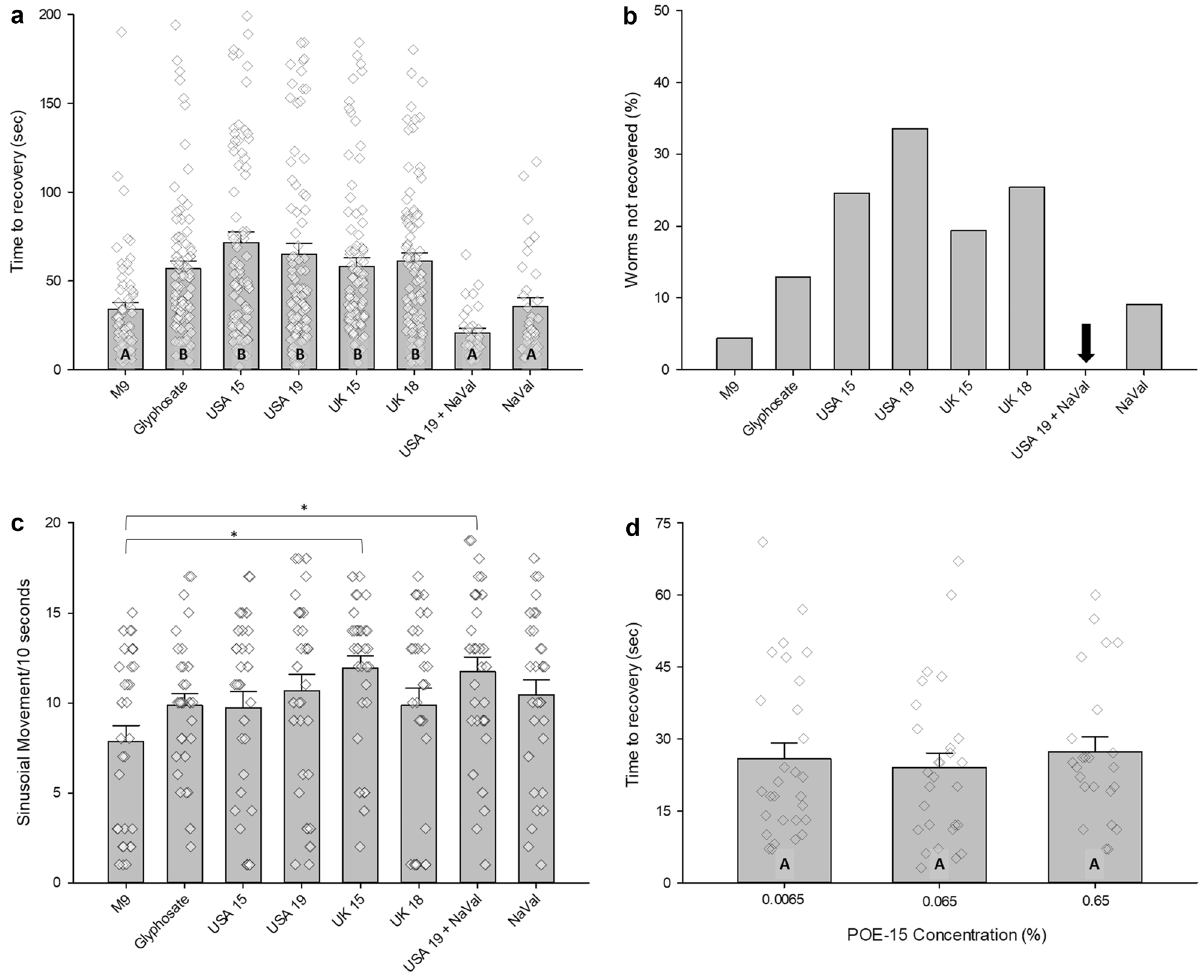
Figure 1. (a ) Average time to recovery for N2-wildtype nematodes, approximately 100 worms per condition, exposed to M9 saline (n = 65), glyphosate (n = 85), US formulations of Roundup from 2015 (n = 85) and 2019 (n = 104), UK formulations of Roundup from 2015 (n = 95) and 2018 (n = 96), the US formulation of Roundup from 2019 co-administered with 3 mM sodium valproate (n = 31), and sodium valproate by itself (n = 33). Glyphosate-containing treatments were normalized to 0.1 mM glyphosate. Data presented as mean seconds to recovery ± SEM. Raw data points were overlayed on the histograms. Statistical significance (p < .05) was designated using letters, where different letters show statistically significant differences, and the same letter indicates non-significance. P values between indicated conditions derived from a One-Way ANOVA followed by Student–Newman–Keuls Method for all pairwise multiple comparisons. ( b ) Percent of worms that did not recover from convulsion state when exposed to M9 saline (n = 69), glyphosate (n = 116), US formulations of Roundup from 2015 (n = 114) and 2019 (n = 158), UK formulations of Roundup from 2015 (n = 119) and 2018 (n = 130), the US formulation of Roundup from 2019 co-administered with 3 mM sodium valproate (n = 31), and sodium valproate by itself (n = 36). Data presented as (number of worms not recovered in condition X/total number of worms tested in condition X) × 100. Arrow indicates that all worms recovered in the condition. ( c ) Average number of complete sinusoidal movements per 10 s before induction of electroshock. N2-wildtype nematodes were exposed to M9 saline (n = 31), glyphosate (n = 32), US formulations of Roundup from 2015 (n = 31) and 2019 (n = 33), UK formulations of Roundup from 2015 (n = 32) and 2018 (n = 33), the US formulation of Roundup from 2019 co-administered with 3 mM sodium valproate (n = 31), and sodium valproate by itself (n = 31). Data presented as mean sinusoidal movement/10 s time window ± SEM. Raw data points were overlayed on the histograms. Statistical significance (p < .05) was designated using stars. P values between indicated conditions derived from Kruskal–Wallis One-Way ANOVA on ranks followed by Dunn’s Method for multiple comparisons versus M9 control group. ( d ) Average time to recovery data for N2-wildtype exposed to logarithmic dosage of percent POE (15) tallow amine, 0.0065% (n = 29), 0.065% (n = 28), and 0.65% (n = 24). Data presented as mean seconds to recovery ± SEM. Raw data points were overlayed on the histograms. P = 0.588, P value derived from Kruskal–Wallis One-Way ANOVA on